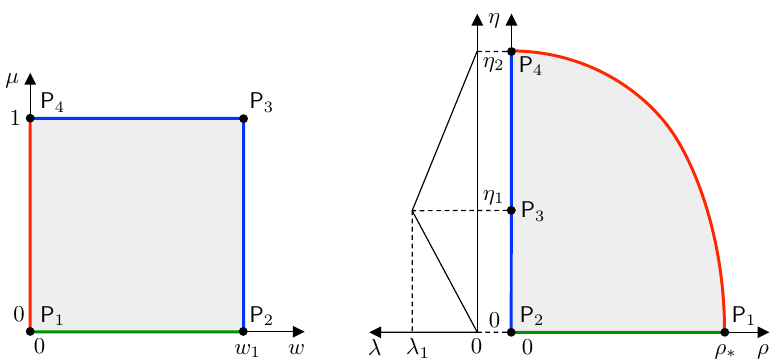
Figure 10. A schematic depiction of the relation between the ( w, µ ) coordinates and ( ρ, η ) co- ordinates. The shaded regions on both sides correspond to the allowed values of the ( w, µ ) , ( ρ, η ) coordinates. On the right, we also include the plot of the charge density λ ( η )